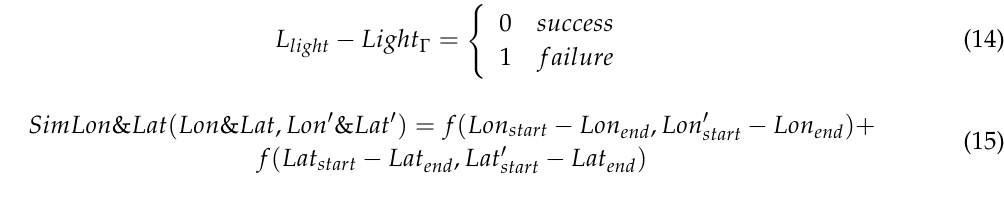
Table 2 is an example of selection of light segment. Light Γ represents the Γ th real-time light data. L light − Light Γ represents the match result of segment data under different light